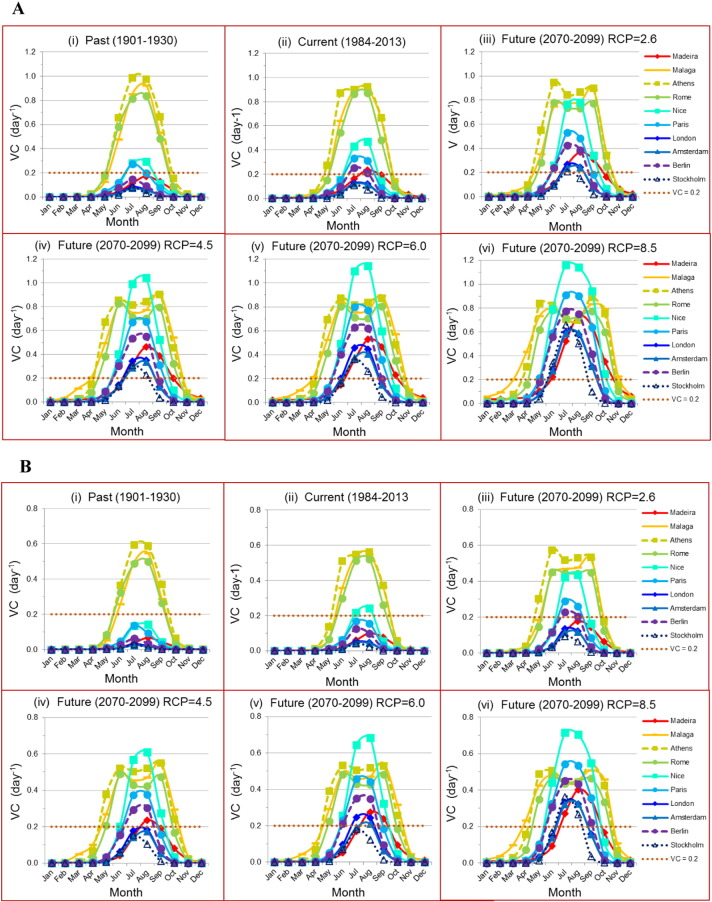
Seasonality comparison in VC among ten European cities over two centuries for Ae. aegypti (A) and Ae. albopictus (B). A 30-year averaged VC was plotted as a function of month for 3 different periods: Past (Fig. 3i), Current (Fig. 3ii), Future (Fig. 3iii–vi) under four different projected climate scenarios or emission pathways (RCP). DTR was included and mmax = 1.5. CRU-TS3.22 (Jones et al., n.d.) and CMIP5 (Taylor et al., 2011) gridded (0.5 × 0.5°) temperature data were used. For each emission scenario, VC was averaged over five different global models (CMIP5 (Taylor et al., 2011, Warszawski et al., 2014)).